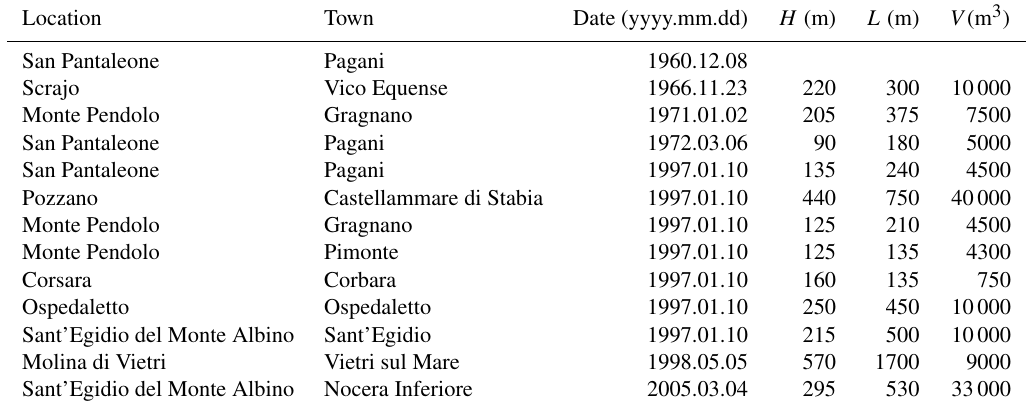
Table 1. Major flow-like landslides triggered since 1950 in the Lattari Mountains ( H is the difference in elevation between the main crown and the tip of the accumulation zone; L is the projection on the horizontal plane of the distance between the crown and the tip; V is the volume of the landslide body) (modified from de Riso et al.,